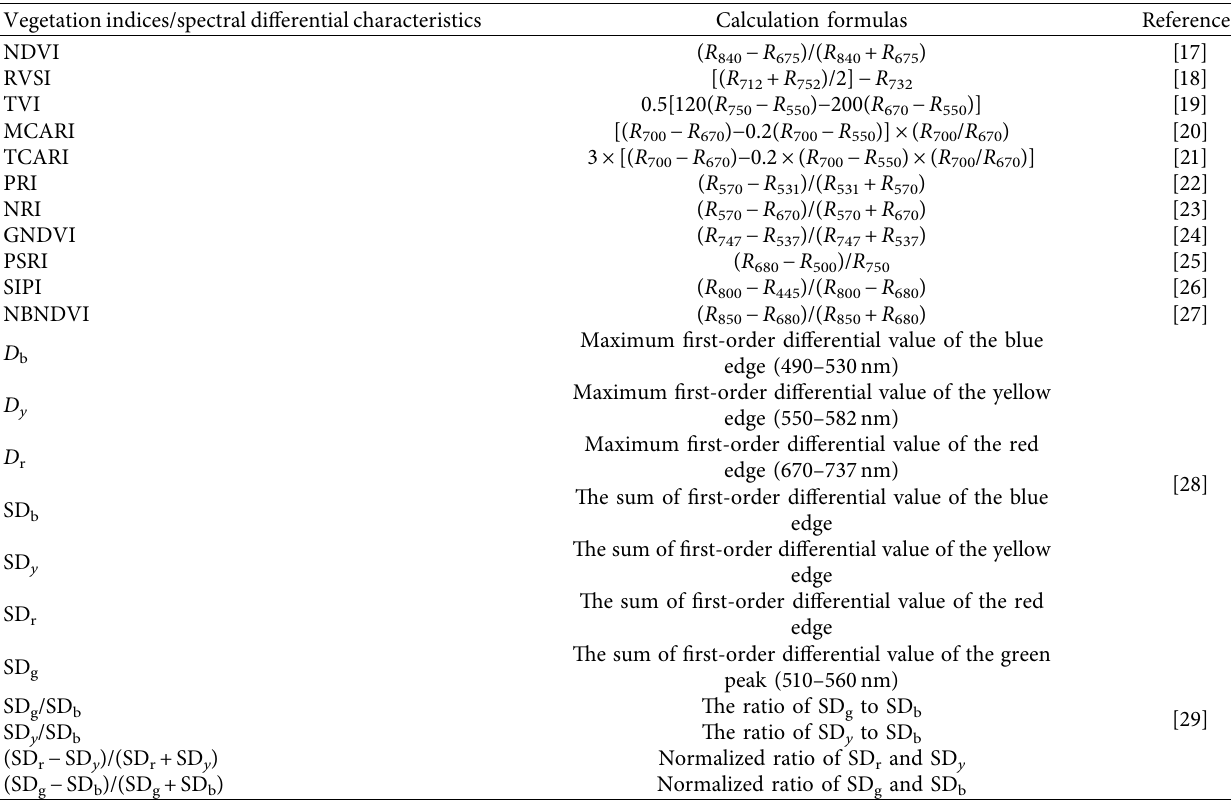
Table 1: Definitions of vegetation indices and spectral differential characteristics. Vegetation indices/spectral differential